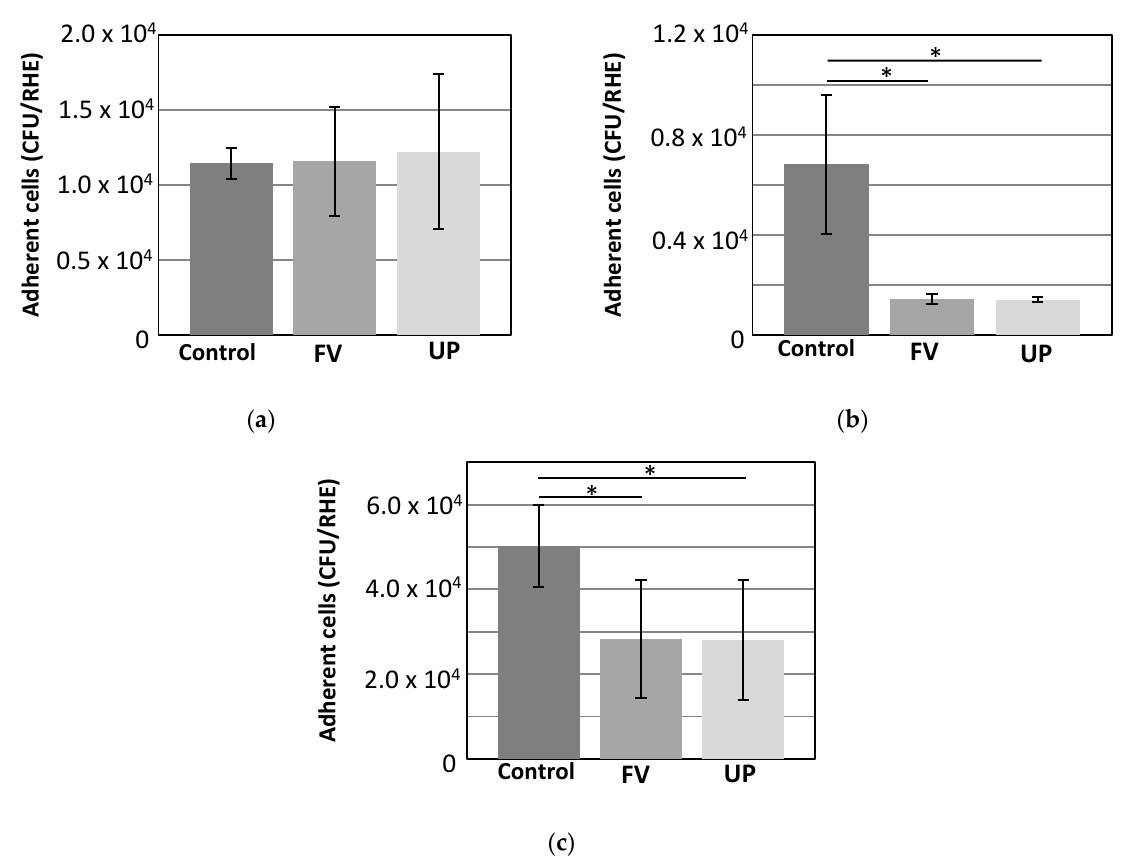
Figure 4. Concentrations of adherent ( a ) S. epidermidis , ( b ) S. aureus and ( c ) C. acnes after topical treatment with FV and UP. The concentrations are expressed in CFU/RHE. The graph represents the means obtained on three independent cultures with three counts for each of them, as well as the standard deviation. The values of 0.001 < p < 0.05 are considered as significant (*). Student’s test compared to control.